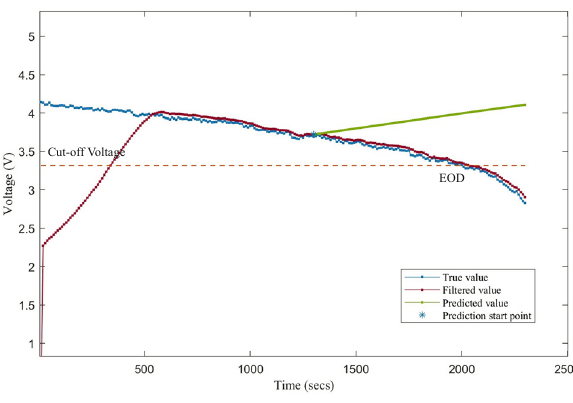
Figure 2: Possible prediction result of original